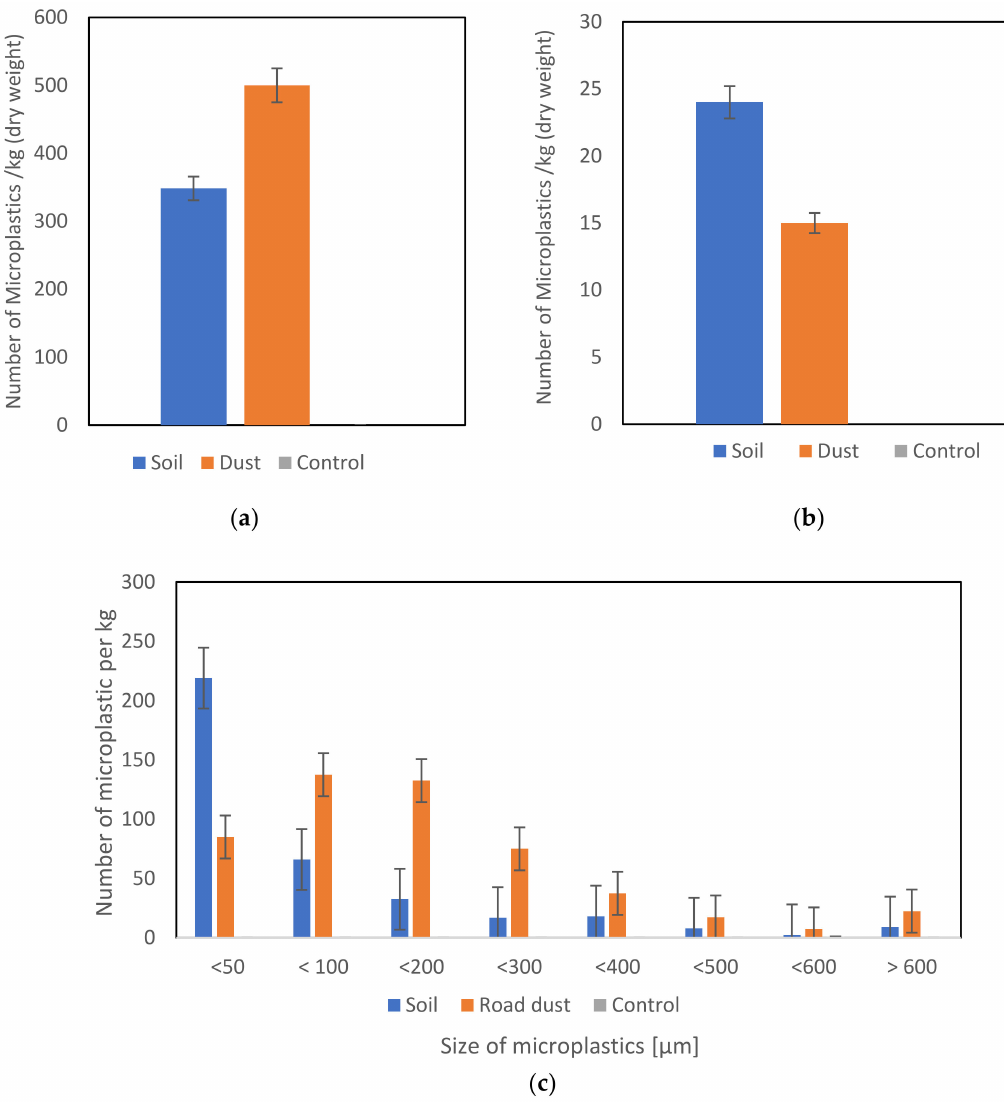
Figure 5. The number of microplastics: ( a ) fragments per kg (dry weight), ( b ) fibres per kg (dry weight), ( c ) number and size of microplastics per kg (dry